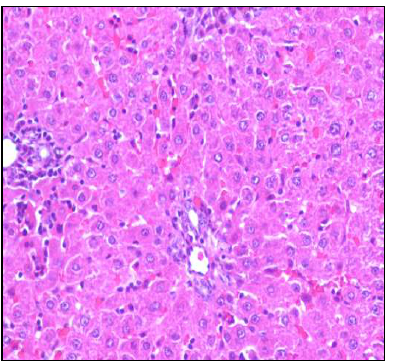
Figure-3. Histopathology image of intestine from Group IV rat showing increased goblet cell activity, destruction and shortening of the villi in repeated 28 day toxicity study by H and E stain (100